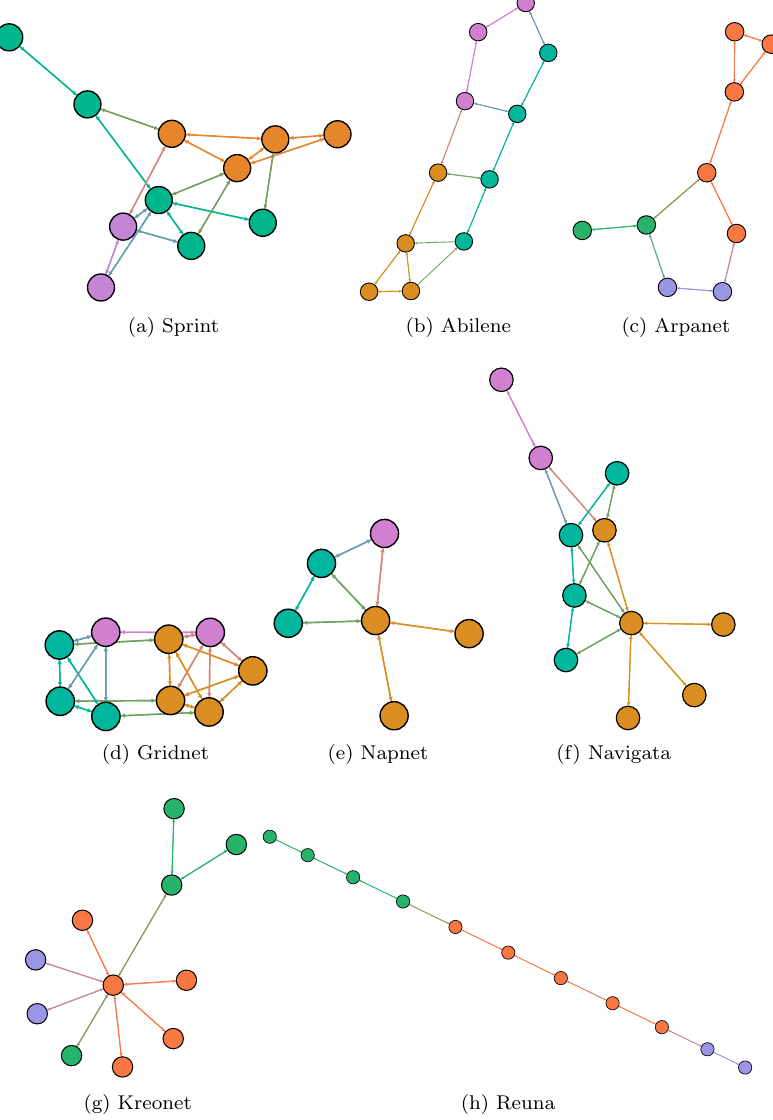
Figure 1: Networks topologies used for placement methods evaluation. Figure 11. Optimal placing the network node devices for each technology for each network topology in Figure